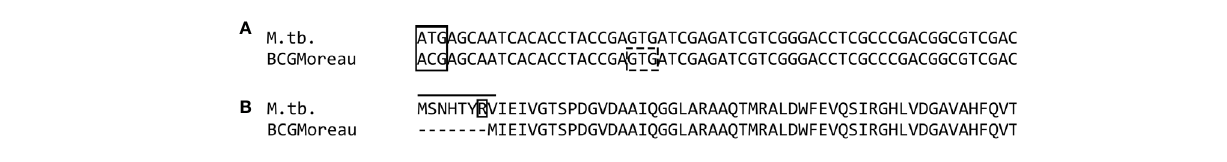
FIGURE 1 | DNA and protein alignment of the dodecin locus. (A) Alignment of dodecin coding regions from M.tb and M. bovis BCG Moreau, showing that a T-C transition (within the solid-line rectangle) leads to the loss of the ATG start codon in BCG and prediction of GTG as the new start codon downstream (dashed-line rectangle). (B) Alignment of the resulting proteins showing the effect of this mutation in BCG, with the loss of seven N-terminal amino acids, including Arg7 (boxed), when compared to M.tb .